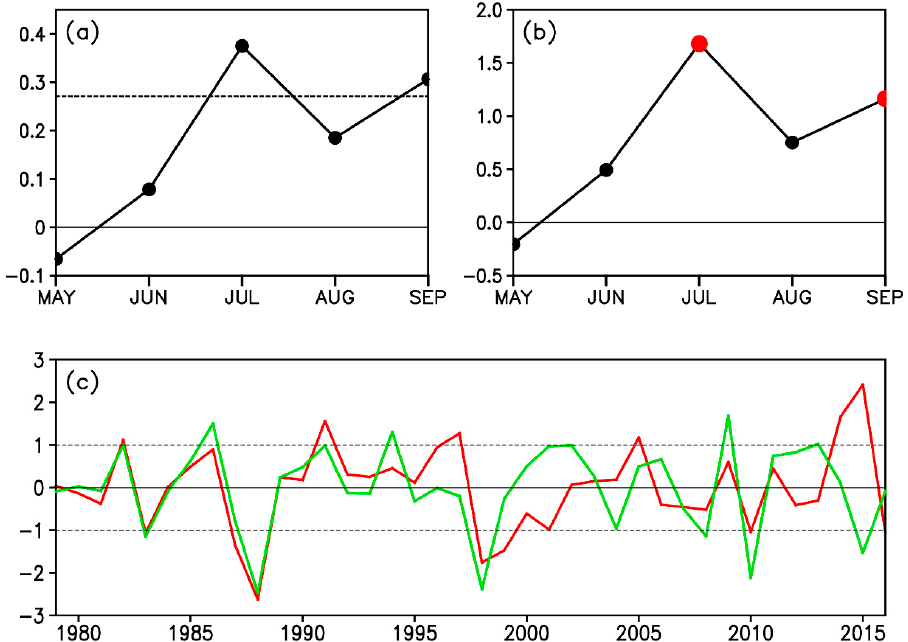
Figure 3. ( a ) Correlations of the February–April (FMA) VM index (VMI) with monthly SCSSMI from May to September. The horizontal dashed line shows the 90% confidence level; ( b ) Composite differences in the monthly evolution of the SCSSMI between strongly positive and negative VM cases. Red closed circles indicate the values significant at the 90% confidence level; ( c ) Time series of the FMA VMI (red line) and the following June–September (JAS) SCSSMI (green line). To further elaborate the lagged relationship between the VM and SCSSM, we performed a singular value decomposition (SVD) analysis [41] of the cross-covariance matrix between the FMA SST anomalies in the North Pacific (20° N–65° N, 125° E–100° W) and the JAS precipitation